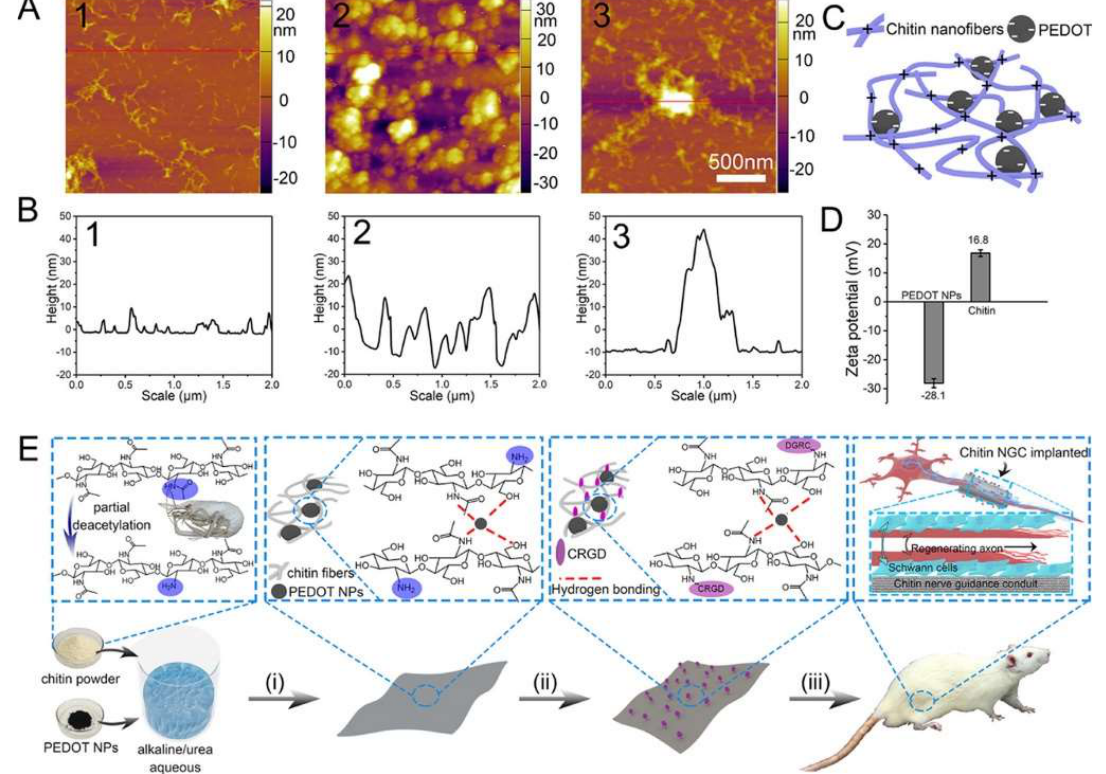
Figure 3. AFM images of the diluted partial deacetylation chitin solution, PEDOT nanoparticles, and chitin blended with PEDOT nanoparticles solution (( A ), 1–3) and the corresponding height graphs (( B ), 1–3). Schematic model of chitin/PEDOT solution ( C ), and ζ–potential of PEDOT NPs